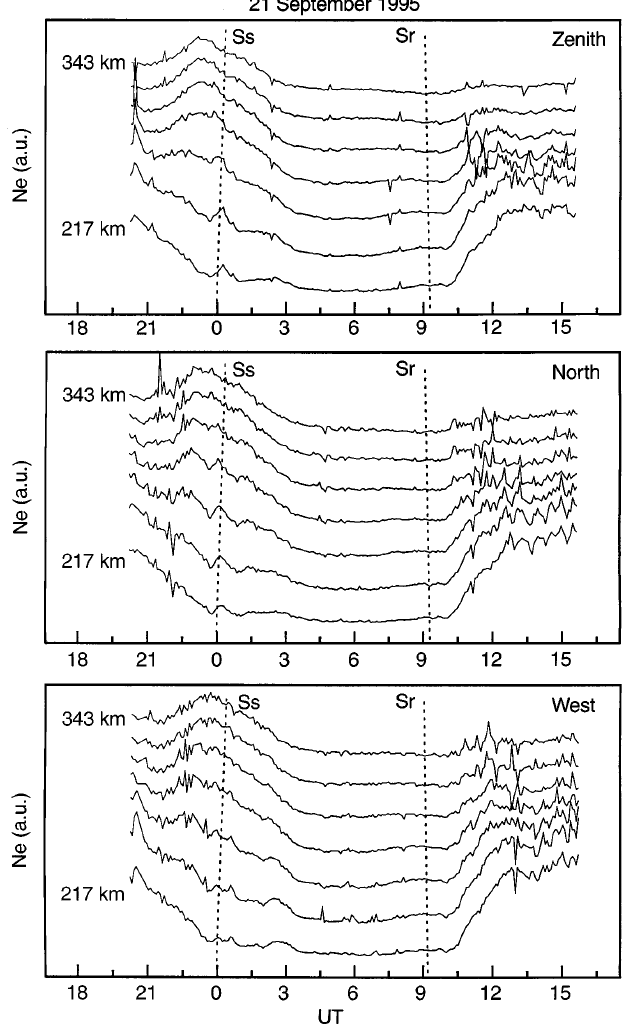
Fig. 2. Unfiltered electron density observations (log 10) observed at several altitudes during the dedicated TID experiment on September 21, 1995 are shown for the three antenna positions of Fig. 1. Curves for di(cid:128)erent heights are artificially shifted to avoid overlapping. Times of the sunset and sunrise terminator passage at ionospheric heights over the observatory are